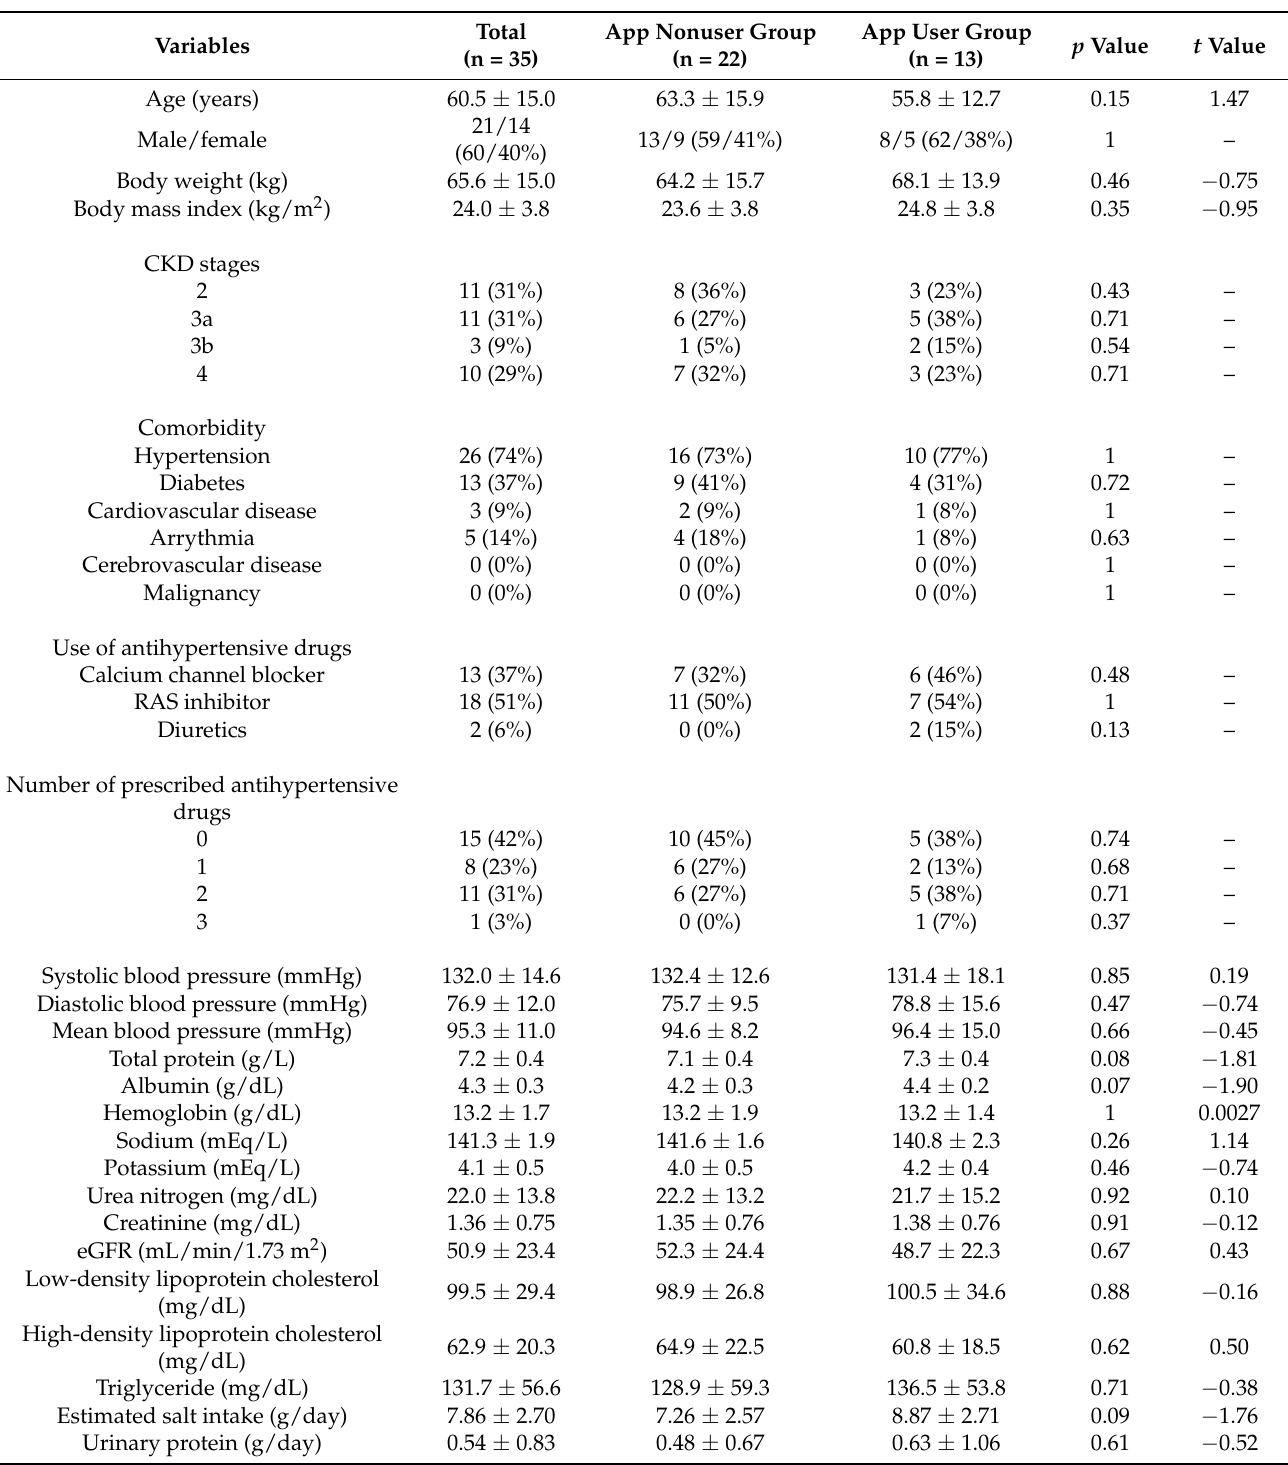
Table 1. Baseline characteristics of the study population and a comparison between the app user and app nonuser